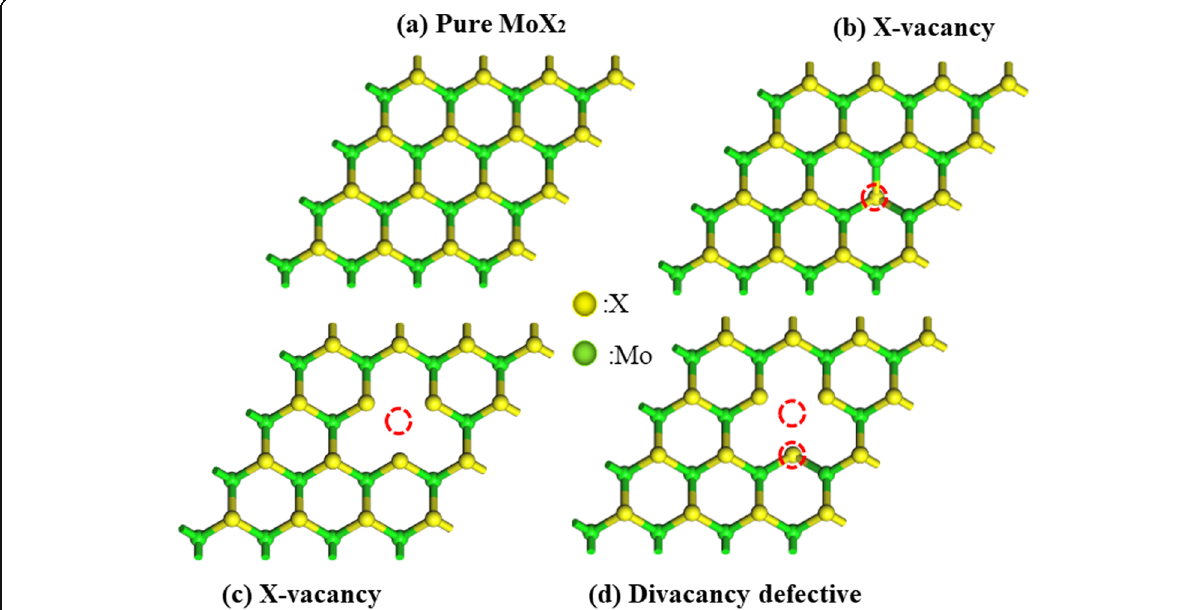
Fig. 2 Top view of MoX 2 with a pure MoX 2 , b S vacancy, c Mo vacancy, and d Divacancy. Green and yellow balls represent Mo and X(S, Se, Te) atoms,